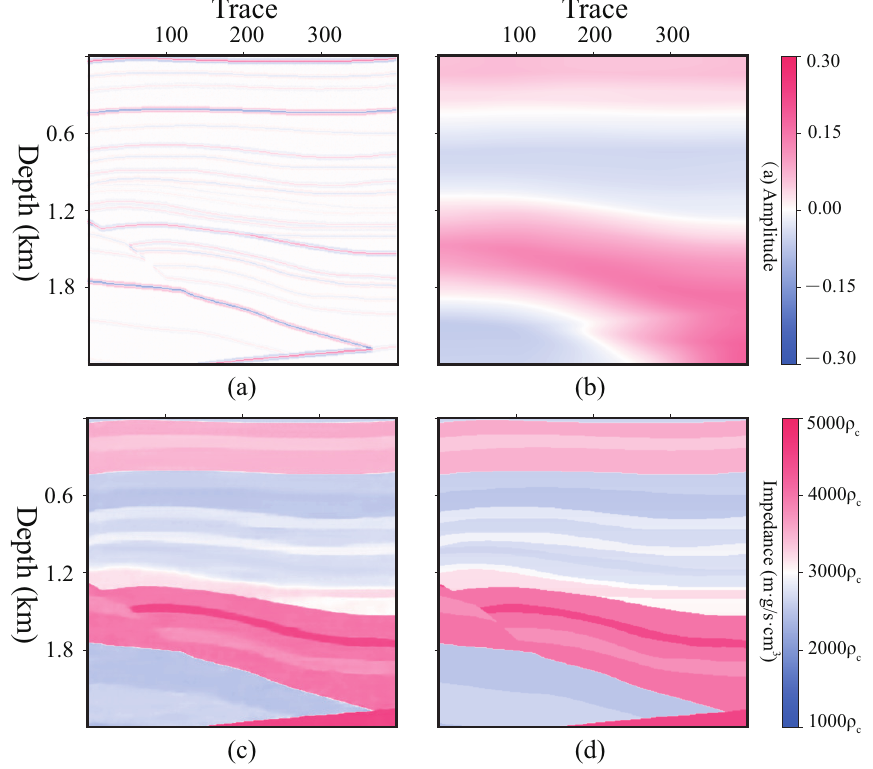
Figure 10. A profile from the test dataset. ( a ) M , channel 1 of input data, K = 0.027, SNR = 3.57 dB, P = − 11 ◦ , ( b ) B , channel 2 of input data, ( c ) predicted profile ˆZ , PCC = 0.9935, R 2 = 0.9427, SSIM = 0.9536, PSNR = 28.04 dB. ( d ) label profile Z .